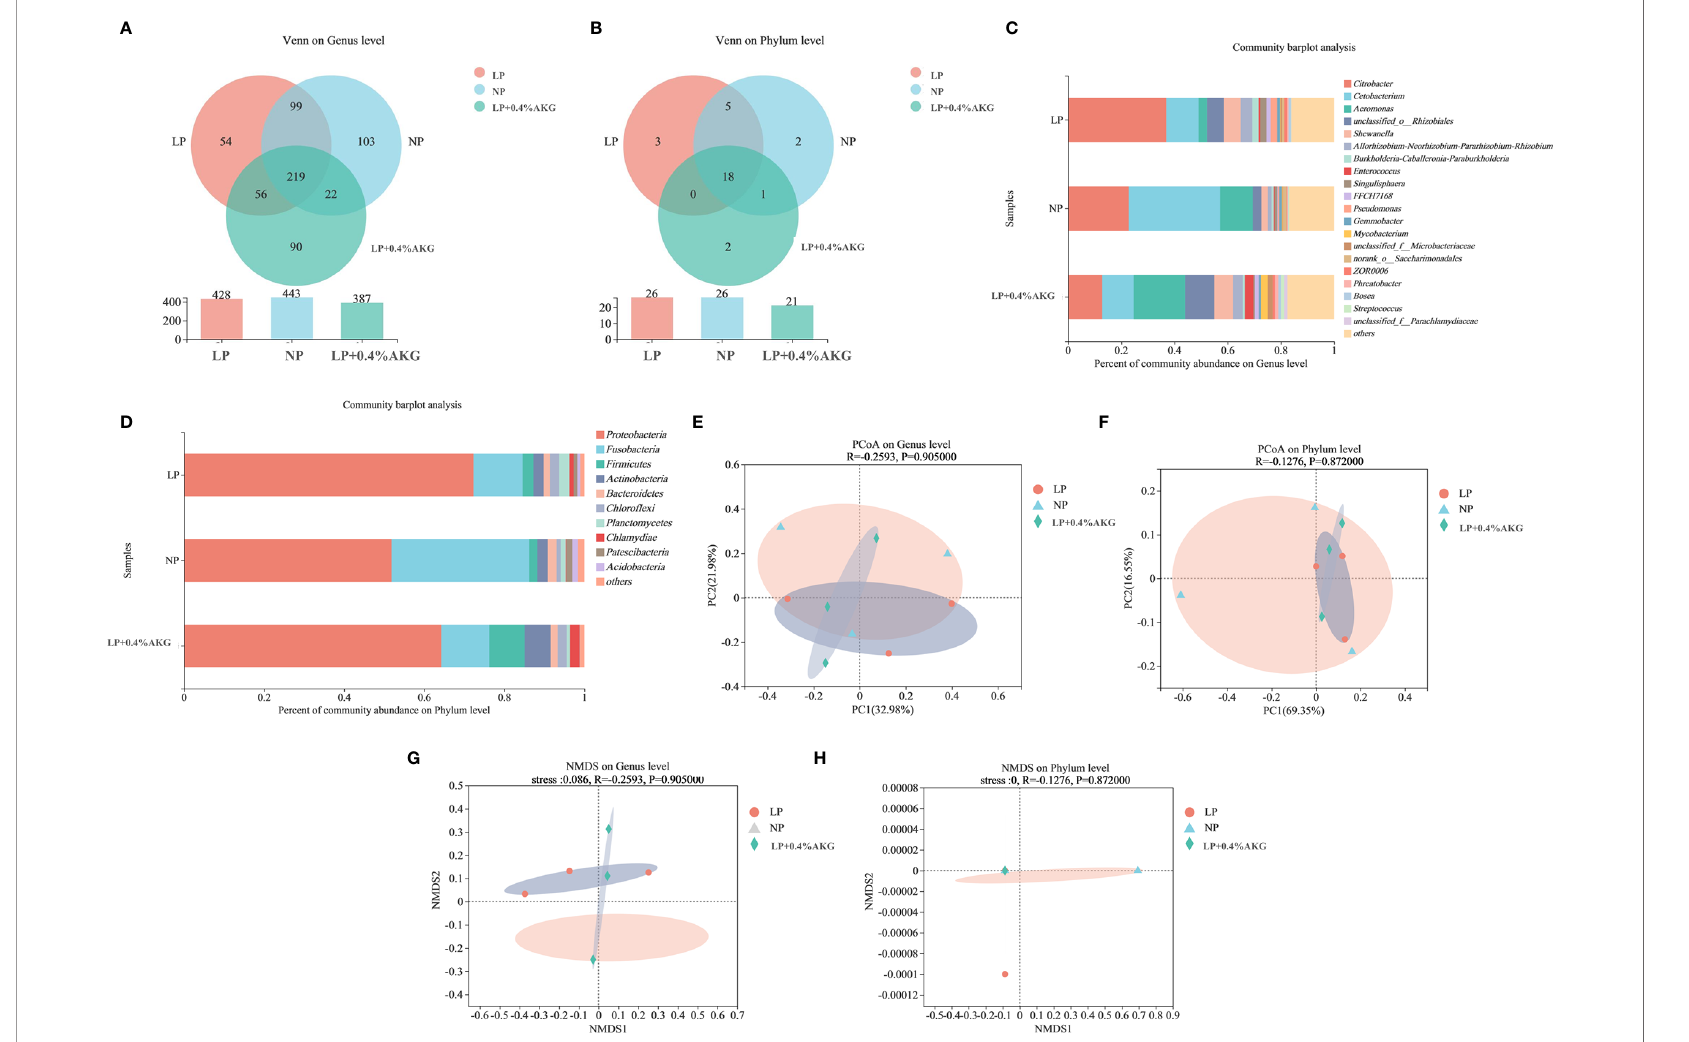
FIGURE 5 | Differences between gut microbiota communities of common carp ( Cyprinus carpio ) fed with diets containing normal protein (NP), low protein (LP), and 0.4% concentrations of alpha-ketoglutarate (AKG) after 8 weeks. (A) Venn diagram on Genus level; (B) Venn diagram on Phylum level; (C) Relative abundance of gut microbes on Genus level; The ordinate is the sample name, the abscissa is the proportion of species in the sample, the columns with different colors represent different species, and the length of the columns represents the proportion of species. (D) Relative abundance of gut microbes on Phylum level. (E) Principal coordinate analysis (PCoA) plot based on unweighted UniFrac distance (PCoA1: 32.98% and PCoA2: 21.98% of the explained variance) on Genus level; (F) PCoA plot based on unweighted UniFrac distance (PCoA1: 69.35% and PCoA2: 16.55% of the explained variance) on Phylum level; (G) Nonmetric multidimensional scaling (NMDS) analysis of bacterial community composition in carp of treatments on Genus level; each symbol represents a sample (circles: LP, triangles: NP, diamond: LP+0.4%AKG). The ellipse was drawn around the position of each group of samples. (H) NMDS analysis of bacterial community composition in carp of treatments on Phylum